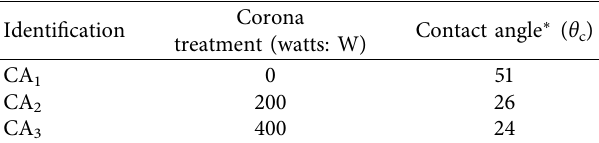
Table 1: Surface tension of BTC subjected to distinct corona treatments.